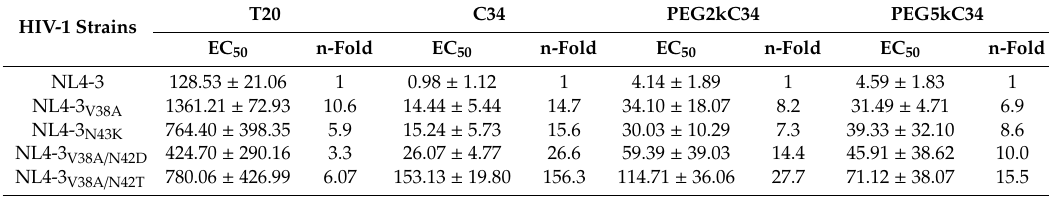
Table 1. Resistance of T20-Induced HIV-1 Mutants to PEGylated HIV-1 Fusion Inhibitors. T20 C34 HIV-1 Strains